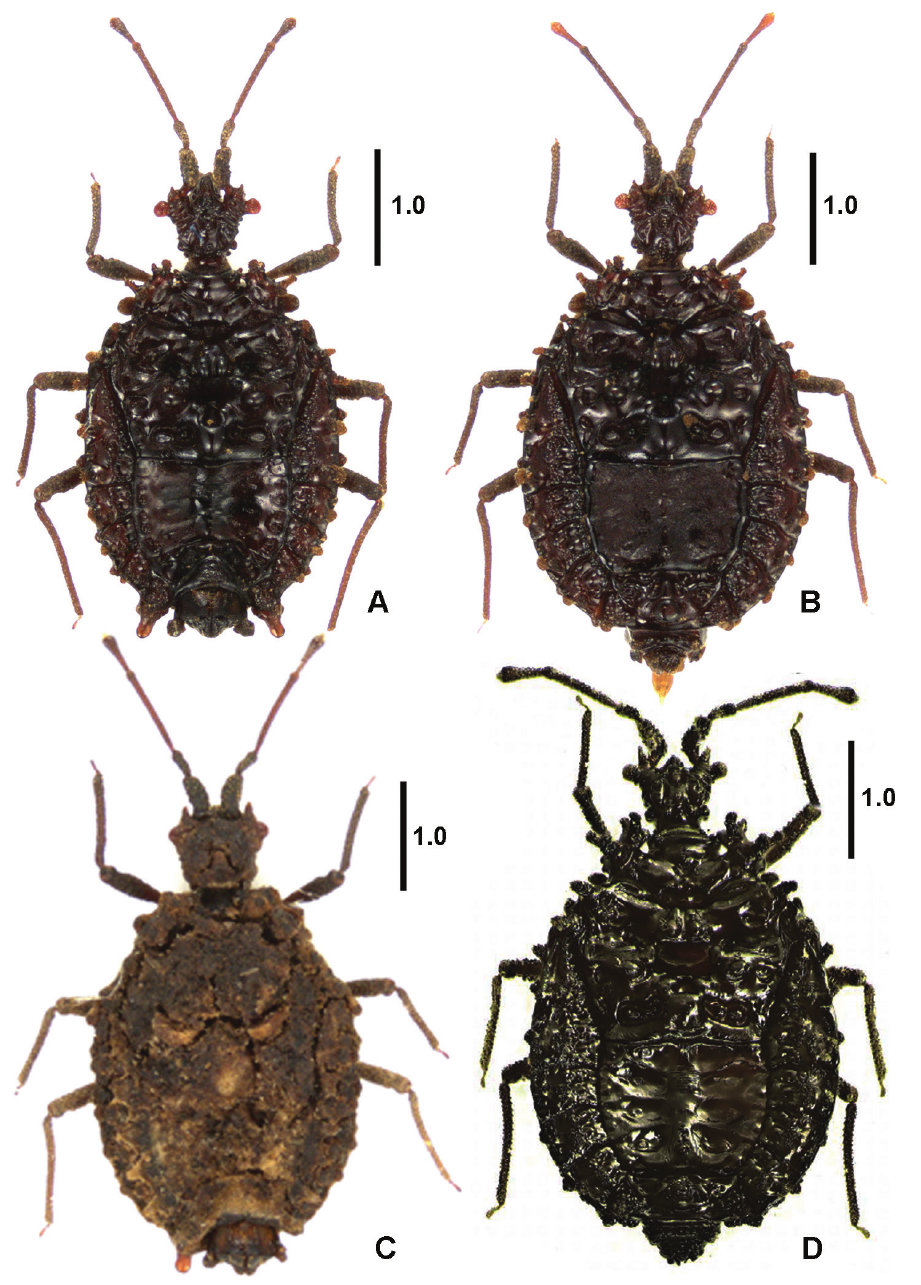
Figure 1. Cervinotaptera species, dorsal habitus. A C. tomhenryi sp. n., male holotype B C. tomhenryi sp. n., female paratype C C. tomhenryi sp. n., male paratype, uncleaned specimen D C. guilberti Heiss & Marchal, 2012, female holotype. Scale bars: 1